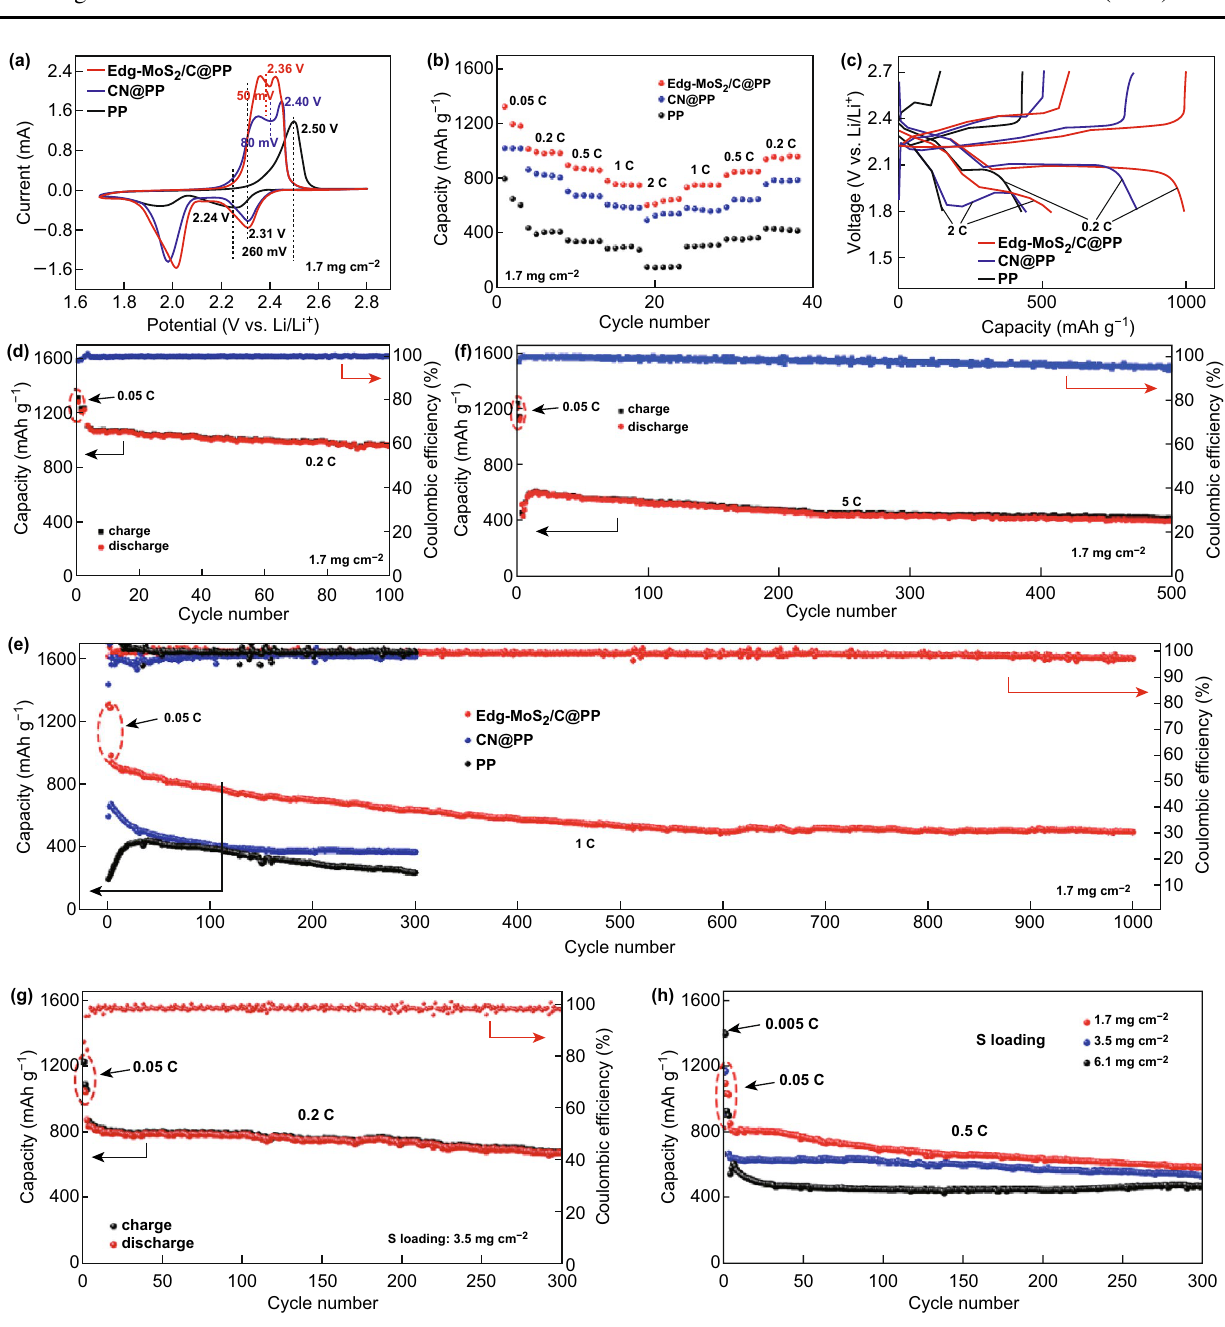
Fig. 3 Electrochemical performances of the CNT/S cathodes with the Edg‑MoS 2 /C@PP and PP separators. a Cyclic voltammogram profiles of the Edg‑MoS 2 /C@PP, CN@PP, and PP cells at a scan rate of 0.1 mV s −1 . b Rate capabilities and c corresponding galvanostatic discharge– charge profiles at 0.2 C and 2.0 C (1 C = 1675 mA g −1 ) of the Edg‑MoS 2 /C@PP, CN@PP, and PP cells. Cycling performances of d the Edg‑ MoS 2 /C@PP cells at 0.2 C, e the Edg‑MoS 2 /C@PP, CN@PP, and PP cells at 1.0 C, f the Edg‑MoS 2 /C@PP cells at 5.0 C. The sulfur loadings of the CNT/S cathodes in a–f are 1.7 mg cm −2 . Cycling performance of the Edg‑MoS 2 /C@PP cells g at 0.2 C with a high sulfur loading of 3.5 mg cm −2 , h at 0.5 C with sulfur loadings of 1.7, 3.5, and 6.1 mg cm −2 , respectively. The weight of the interlayers in all cells is 0.34 mg cm